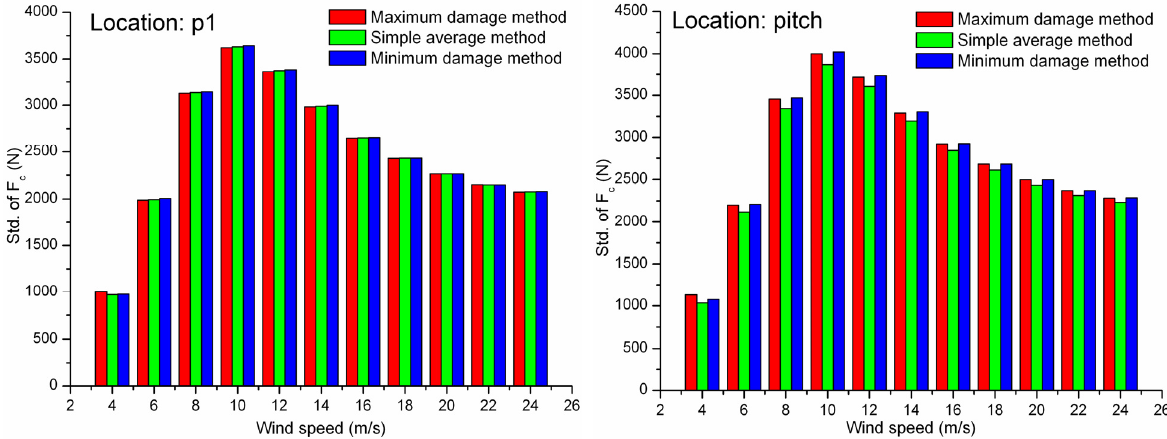
Figure 21. Comparison of standard deviations of contact forces when using different methods at different contact points and wind speeds (4P